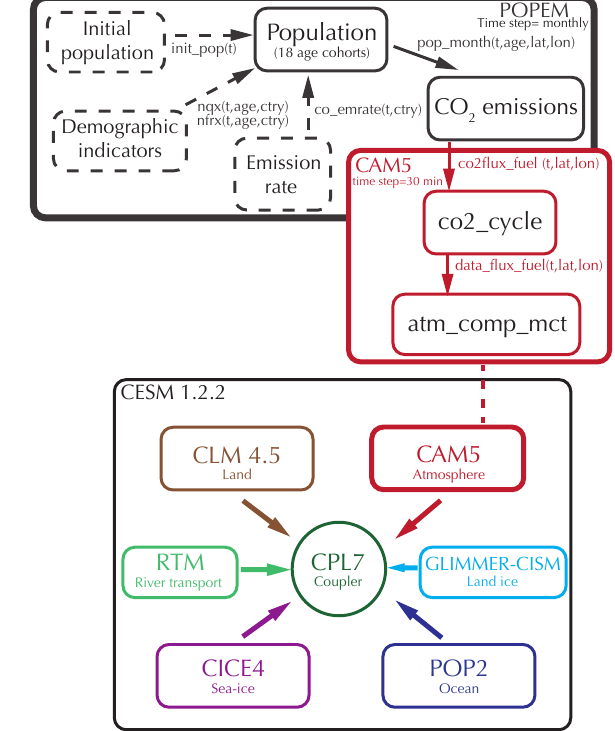
Figure 1. Conceptual scheme of the POPEM module coupled with the CAM5 atmosphere module. POPEM requires three in- put data sets to compute emissions (black dashed rectangles): ini- tial population distribution; demographic parameters (age structure, death, and birth rates); and per capita emission rates by country. POPEM provides a 3-D array (time, latitude, longitude) with emis- sions that are read by the co2_cycle module and passed to the atm_comp_mct module which computes the total amount of CO 2 in the atmosphere.